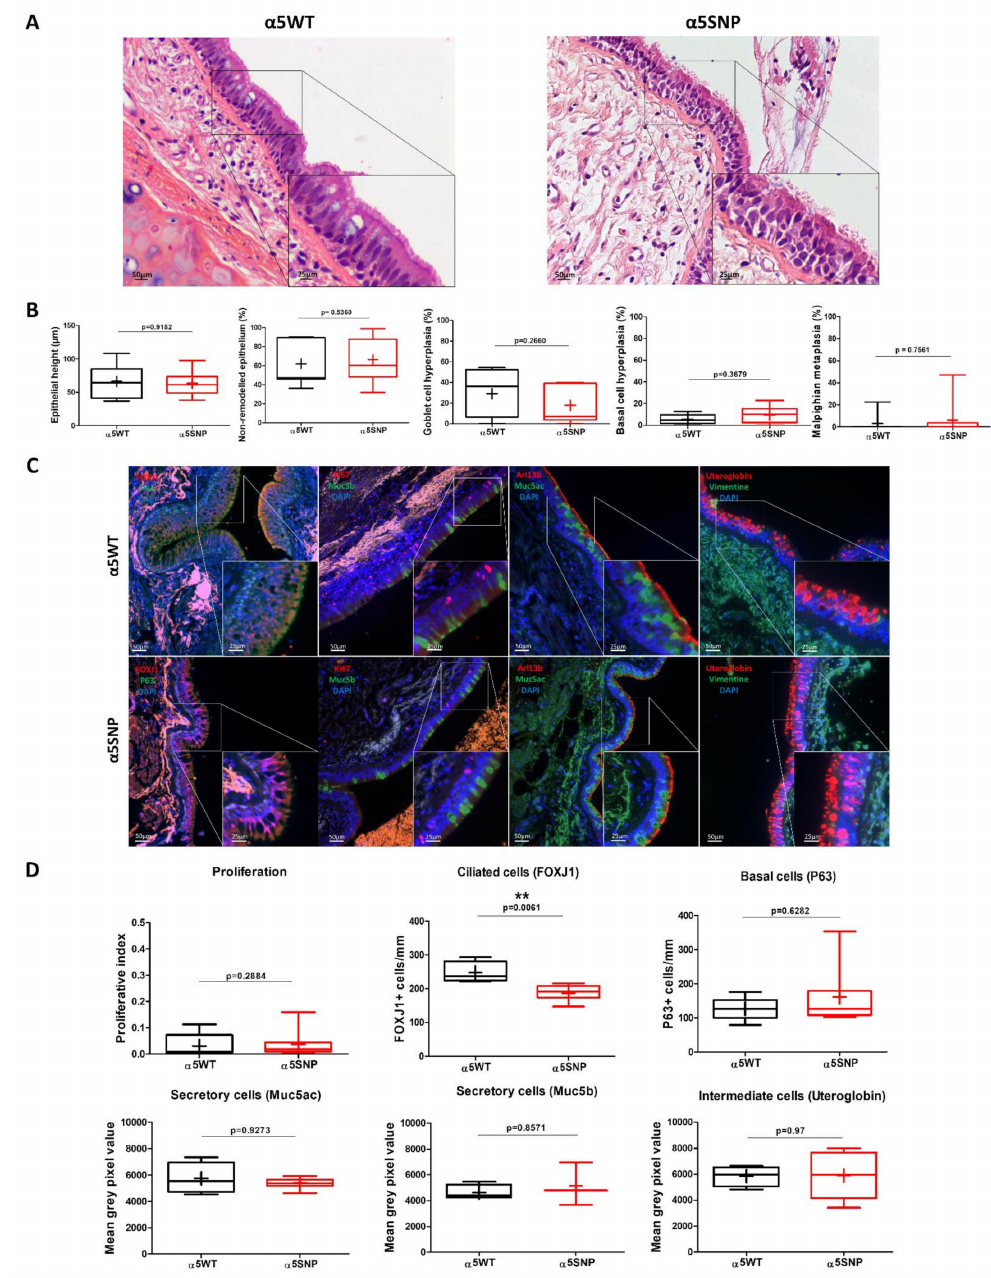
Figure 1. SNP rs16969968 is associated with a decrease in multiciliated cells in bronchi epithelia. ( A ) Representative micrographs showing the bronchial epithelia of α 5WT- and α 5SNP-expressing patients stained for haematoxylin and eosin. Magnification corresponding to the selected area is shown. ( B ) Box and whisker plots (median with min to max, the plus sign (+) represents the mean value) represent the measurements of epithelium height ( µ m), and the percentage of non-remodelled and remodelled (basal cell hyperplasia, goblet cell hyperplasia and metaplasia) epithelium in α 5WT (black) and α 5SNP-expressing (red) groups (n ≥ 7 for each group). ( C ) Representative micrographs showing the bronchial epithelia of α 5WT and α 5SNP-expressing patients stained for ciliated cells (Arl13b and FOXJ1, red), intermediate cells (uteroglobin, red), proliferative cells (Ki67, red), basal cells (P63, green), mucin-secreting cells (Muc5ac and Muc5b, green), intermediate filaments (vimentin, green) and cell nuclei (DAPI, blue). Magnification corresponding to the selected area is shown. ( D ) Box and whisker plots (median with min to max, the plus sign (+) represents the mean value) report the proportion of FOXJ1- and P63-positive cells per mm, the proliferative index, and the mean grey pixel values of mucin- and uteroglobin-associated fluorescence in α 5WT (black) and α 5SNP-expressing cells (red) (n ≥ 3 for each group). ** p < 0.01 α 5WT vs. α